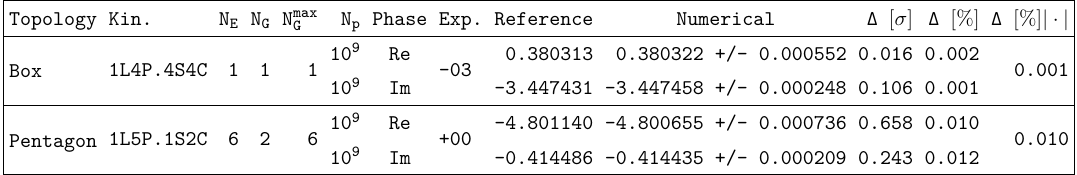
Table 7. Two scalar one-loop integrals whose infrared singularities were subtracted with local counterterms. The reference result for the box is from [32] and the pentagon result was obtained with MadLoop [80,